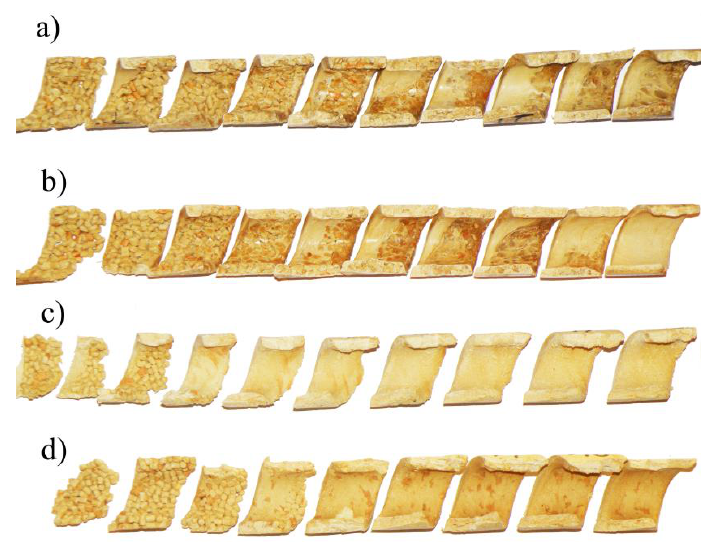
Figure 3. The effect of wood flour (WF) content on the material flow in the screw channel (samples of the material of different wood content removed from the screw, obtained by extrusion at the screw speed N = 50 rpm): ( a ) WF = 30%, ( b ) WF = 40%, ( c ) WF = 50%, ( d ) WF = 60%.